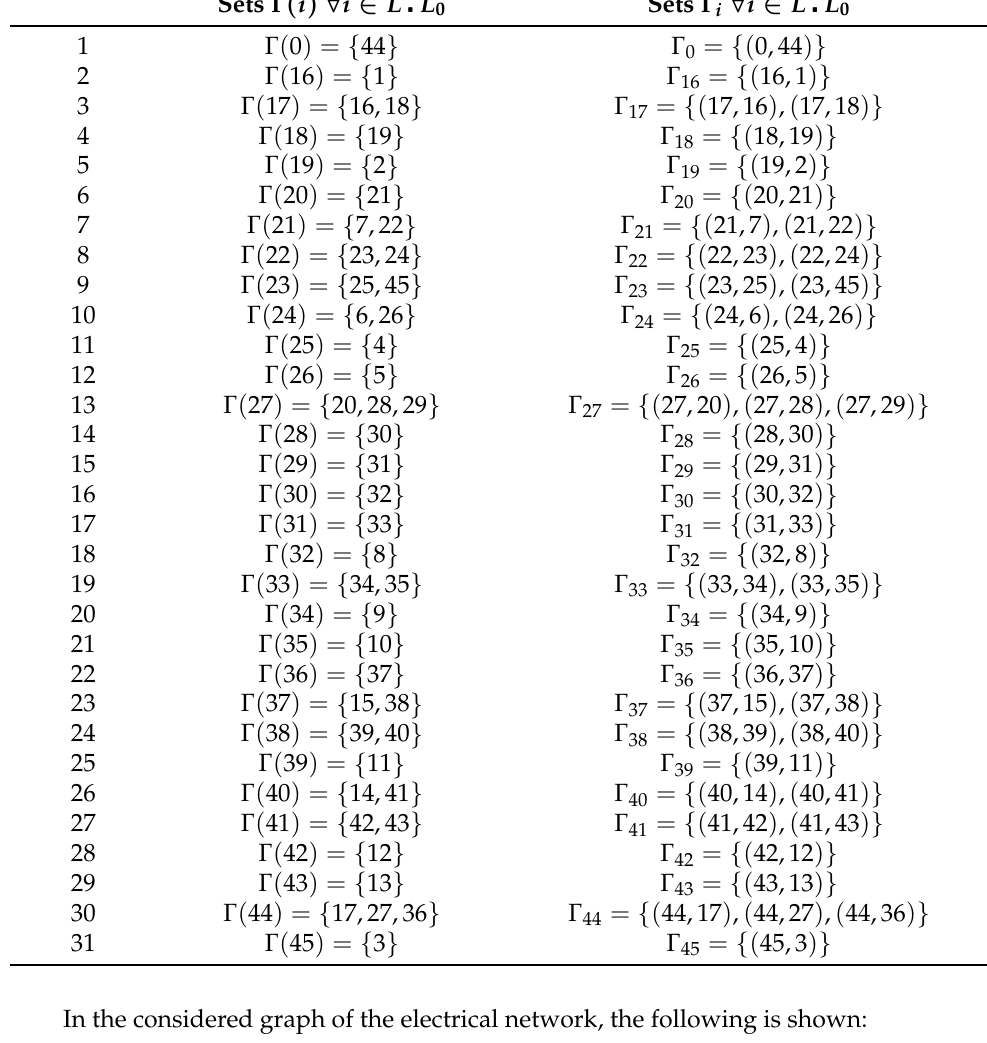
Table 2. Sets Γ ( i ) and Γ i , ∀ i ∈ L \ L 0 . Sets Γ ( i ) ∀ i ∈ L (cid:5) L